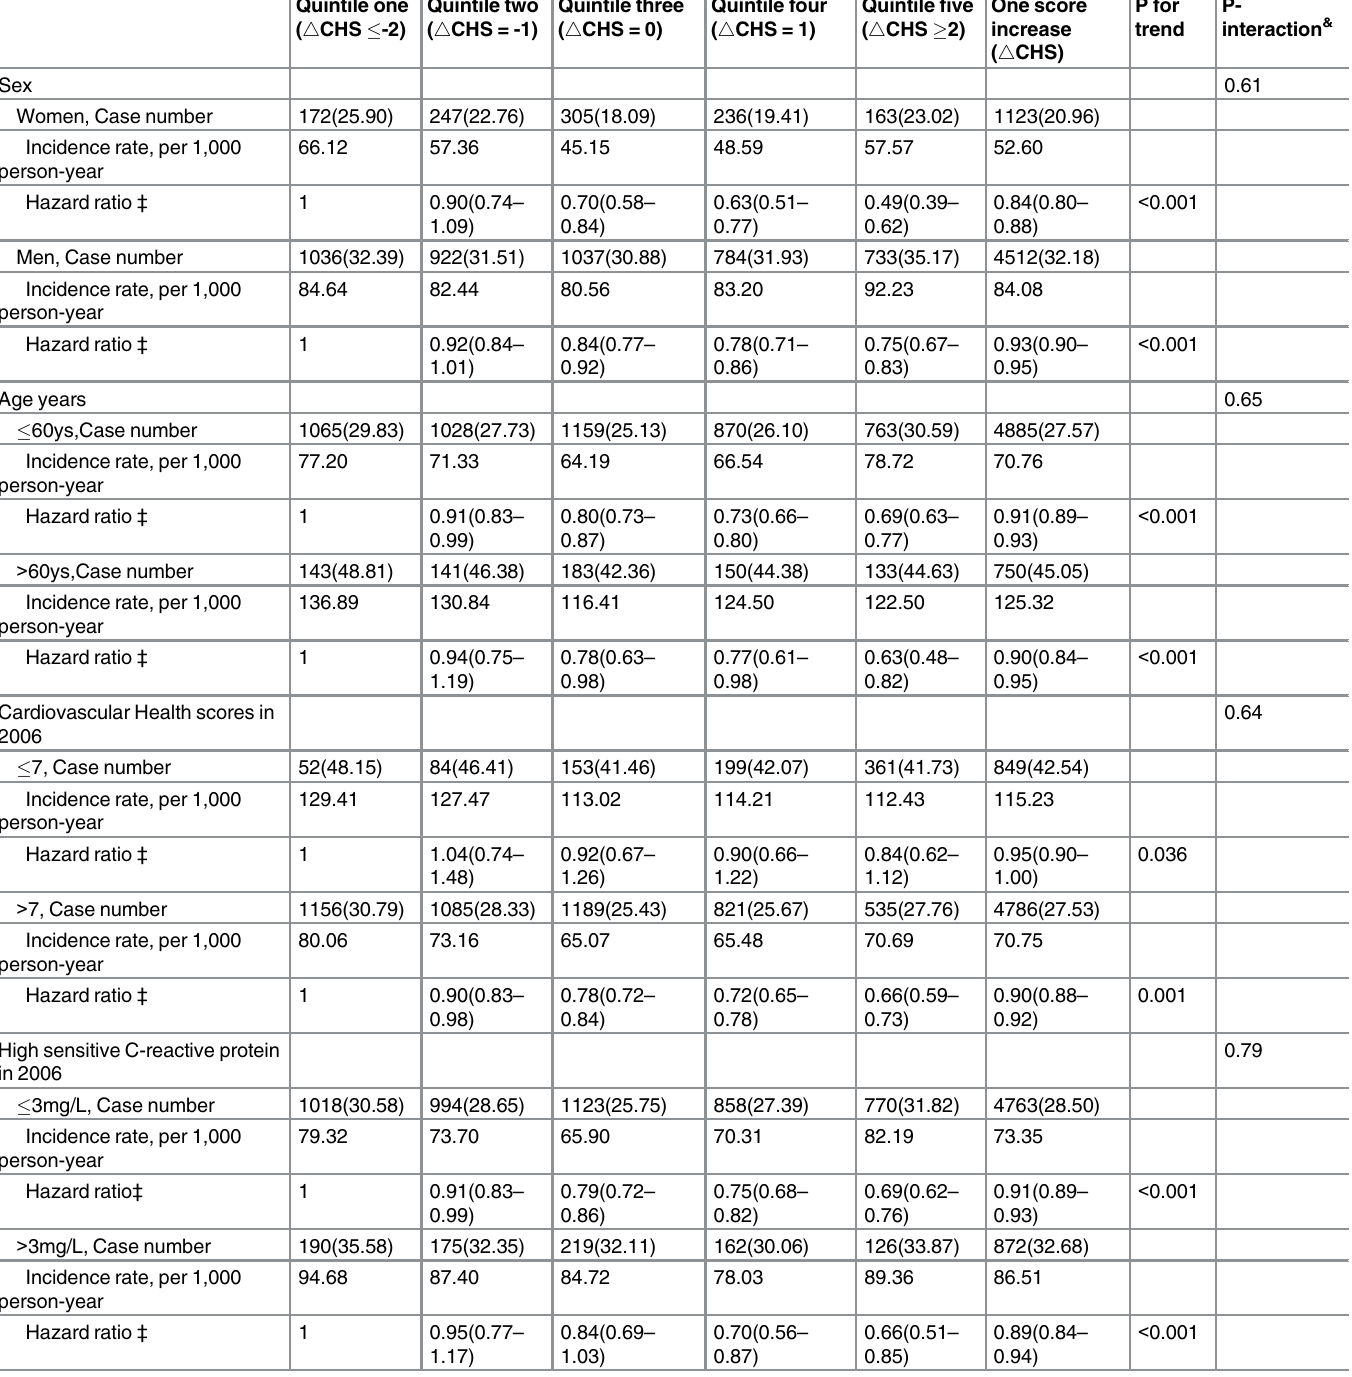
Table 4. Incidence of hypertension in different groups according to the 4